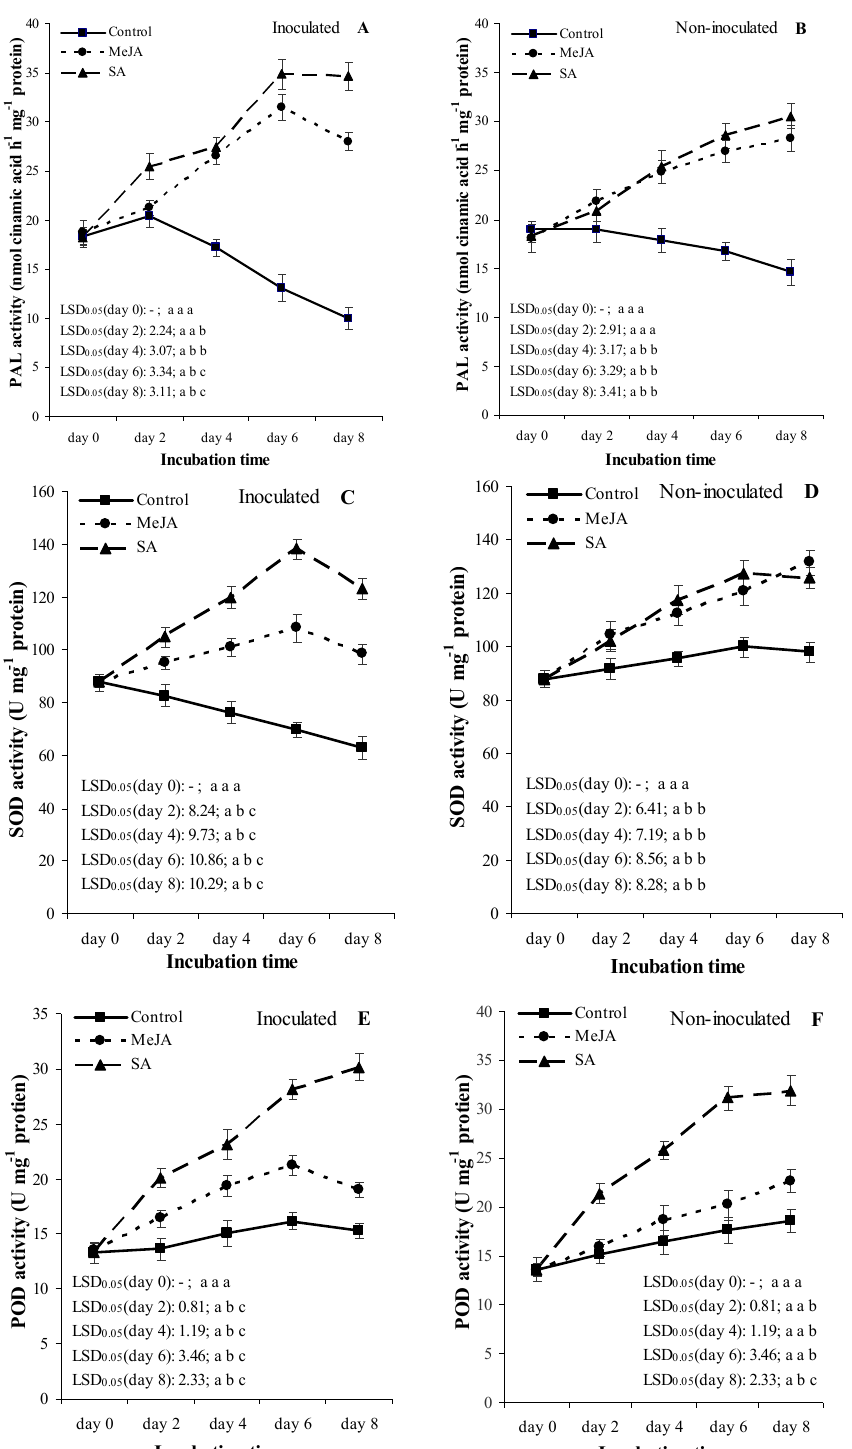
Figure 4. Effect of 2 mmol L − 1 salicylic acid (SA) and 0.4 mmol L − 1 methyl jasmonate (MeJA) on phenylalanine ammonia-lyase (PAL; nmol cinnamic acid h − 1 mg − 1 protein) activity ( A , B ), on superoxide dismutase (SOD; U mg − 1 protein) activity ( C , D ) and on peroxidase (POD; U mg − 1 protein) activity ( E , F ) in apricot fruit (cultivar ‘Bergarouge’) in treatments inoculated against Monilinia laxa ( A , C ) and non-inoculated ( B , D ) fruits assessed at days 0, 2, 4, 6 and 8 after treatment began. Information on symbols, error bars and letters for LSD 0.05 values is presented in Figure 1. Table 2. Pearson’s correlation coefficients ( r ) and their corresponding significance levels ( p ) amongst 7 fruit measures on apricot cultivar ‘Bergarouge’ for inoculated fruits with methyl jasmonate (0.4 mmol L −1 ) and salicylic acid treatments (2 mmol L −1 ). Data were combined for the assessment days 0, 2, 4, 6 and 8 in the SL storage period. Bold figures represent the significant ( p < 0.05) correlation coefficient values.